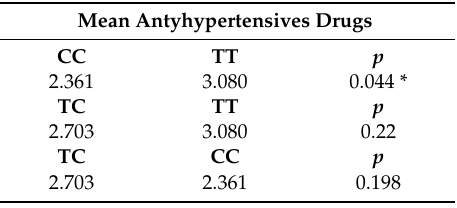
Table 2. Mean antihypertensives drug.